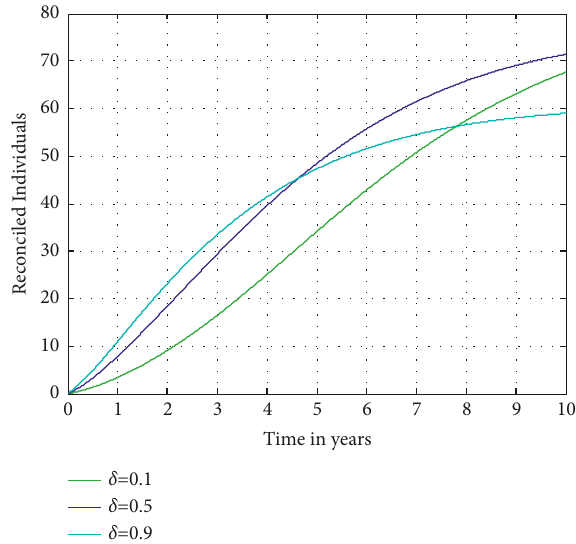
Figure 7: Effect of the reconciled rate δ on the reconciled indi- viduals R.